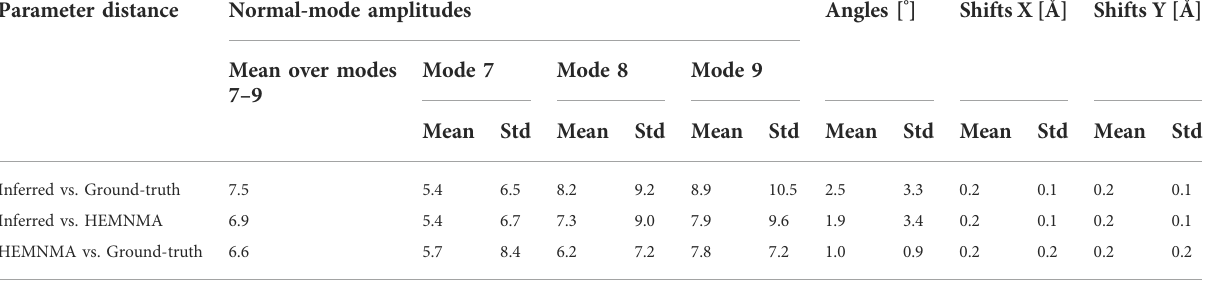
TABLE 1 Mean and standard deviation (Std) of the distance between inferred, ground-truth, and HEMNMA-estimated values of parameters (normal- mode amplitudes, angles, and shifts) for a small test set of 2,000 synthetic images (the data used for quick tests at the training step). Parameter distance